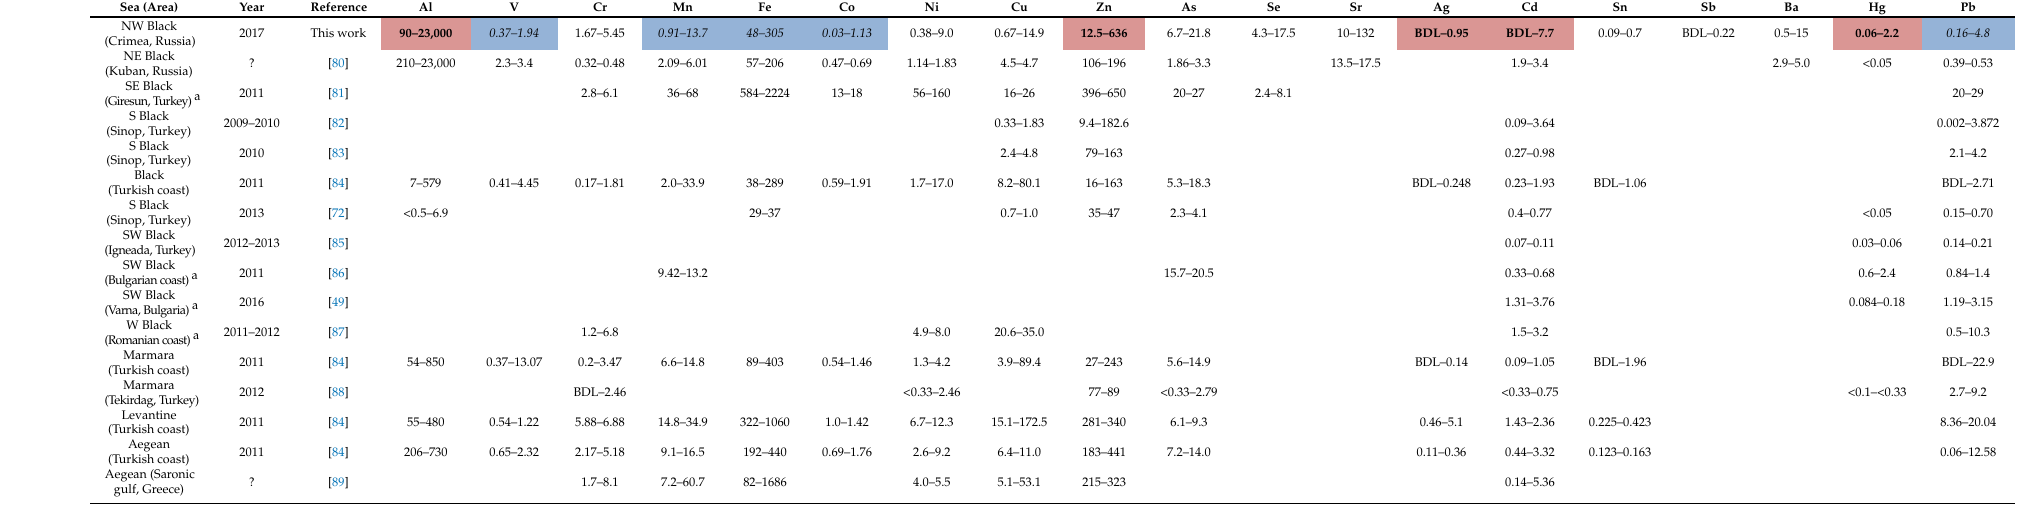
Table 5. Element contents (min–max) in soft tissues of the mussel Mytilus galloprovincialis collected in the 2010s in different areas of the Eastern Mediterranean and Black Sea. NW = northwestern, NE = northeastern, SE = southeastern, etc. BDL: below detection level. Bold (red shading)/italic (blue shading) emphasis: mean values distinctly higher/lower than the respective medians over the